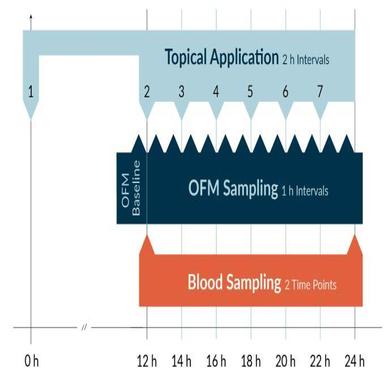
Timing of topical application, dOFM, and blood sampling.